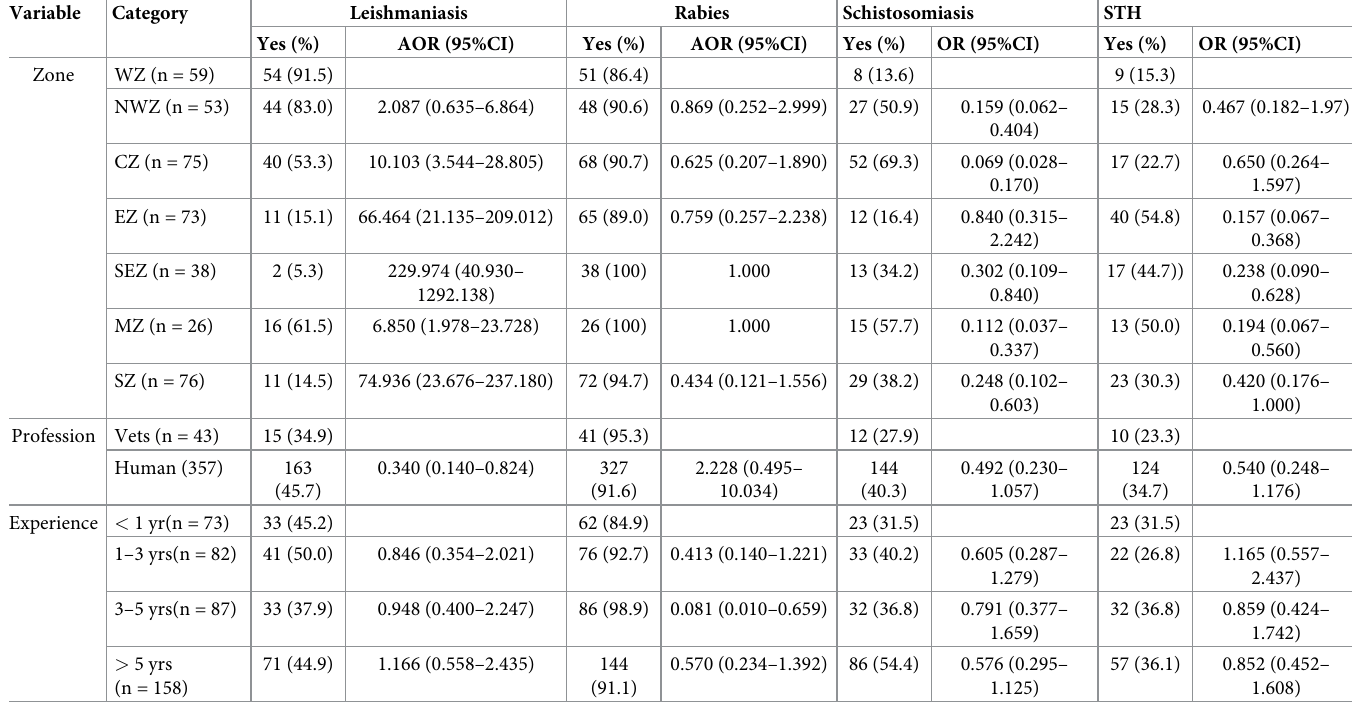
Table 4. Multivariable analysis of leishmaniasis, rabies, schistosomiasis and STH as major zoonoses against the zone, profession, and work